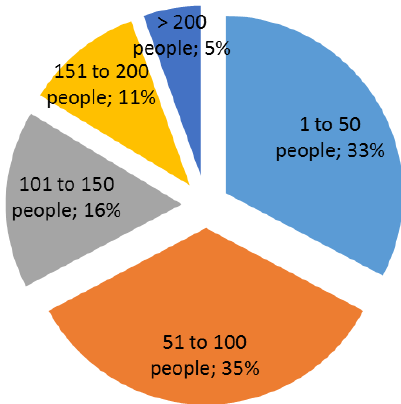
Figure 1. Size of Spanish academic libraries in terms of staff.